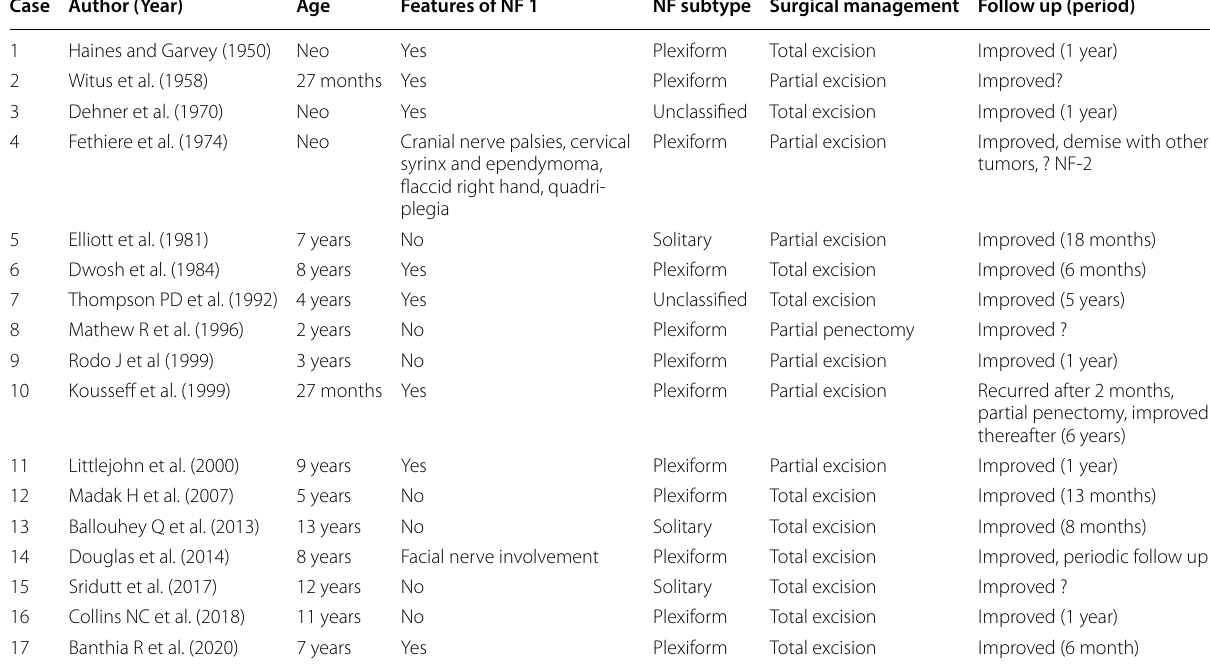
Table 1 Pediatric patients (below 16 year) with primary penile